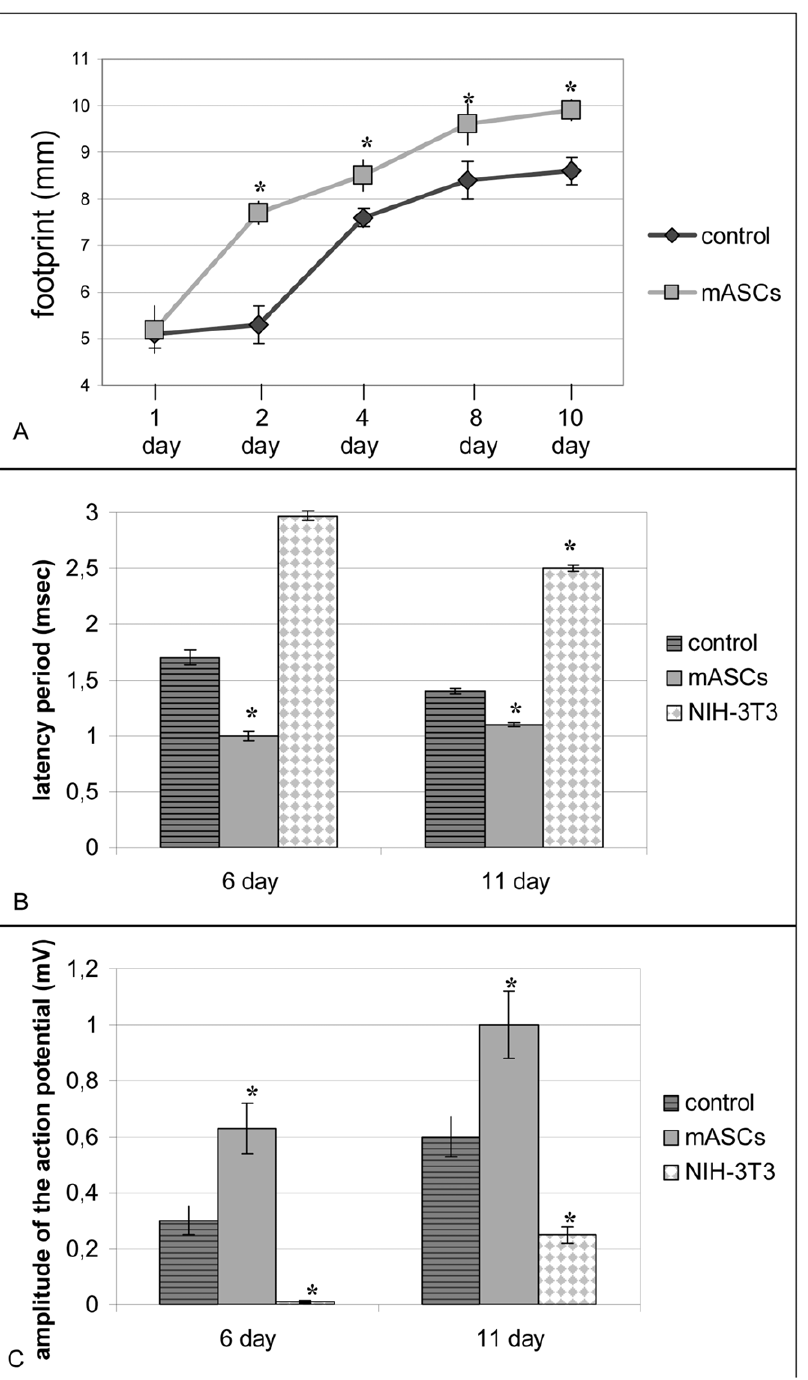
Figure 1. Recovery of common peroneal nerve functioning after mASCs transplantation. A.– peroneal function index (PFI) recovery (motor nerve functioning). B, C. – recovery of nerve conduction velocity (sensory nerve functioning): B. – action potential amplitude; C. - latency period. * - p , 0.05.